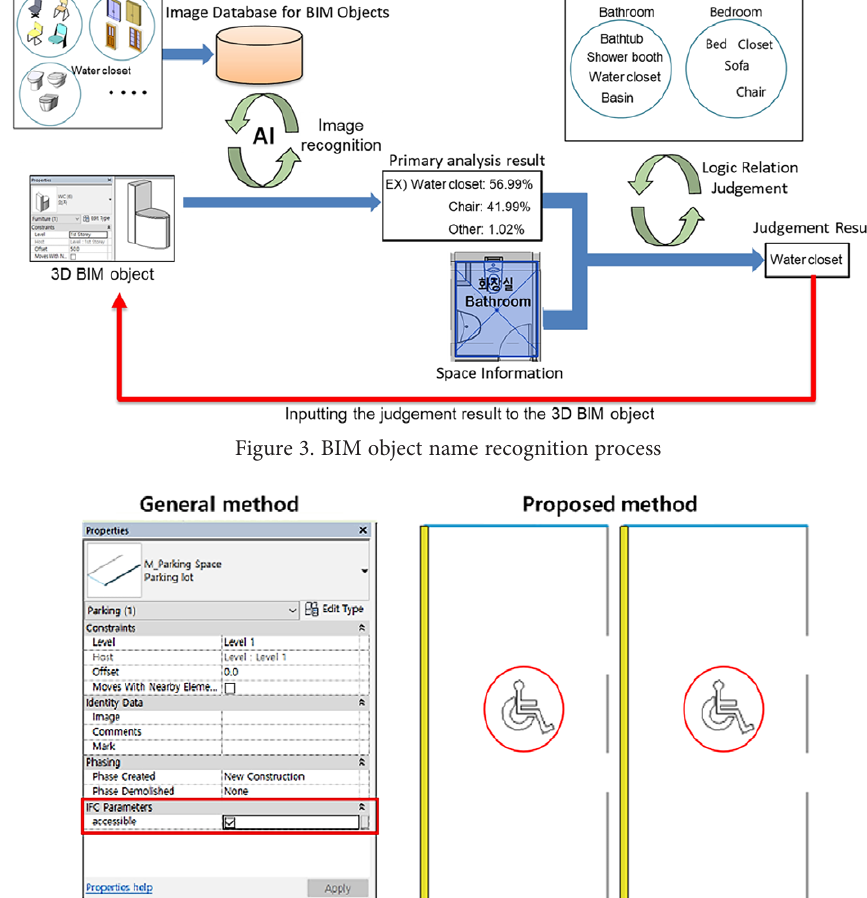
Figure 4. General method (adding “accessible” property to BIM objects) and proposed method (adding visible features to BIM objects) (Sun et al.,